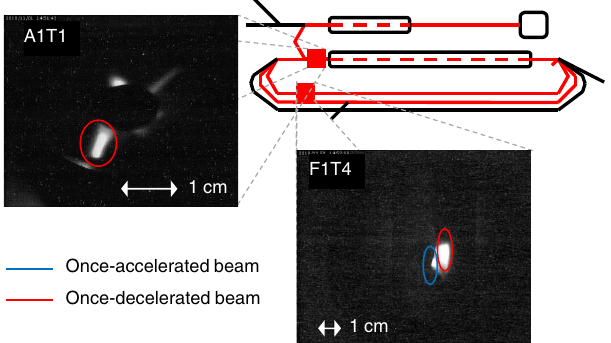
FIG. 10. BeO targets with hole show the position of the once- decelerated beam at the end of the straight section of the first recirculation beamline (F1T4, red circle) and in front of the main accelerator (A1T1, red circle). The once-accelerated beam is passing fully through the hole of A1T1. On F1T4 only a part of the once-accelerated beam (blue circle) is visible and not passing through the hole